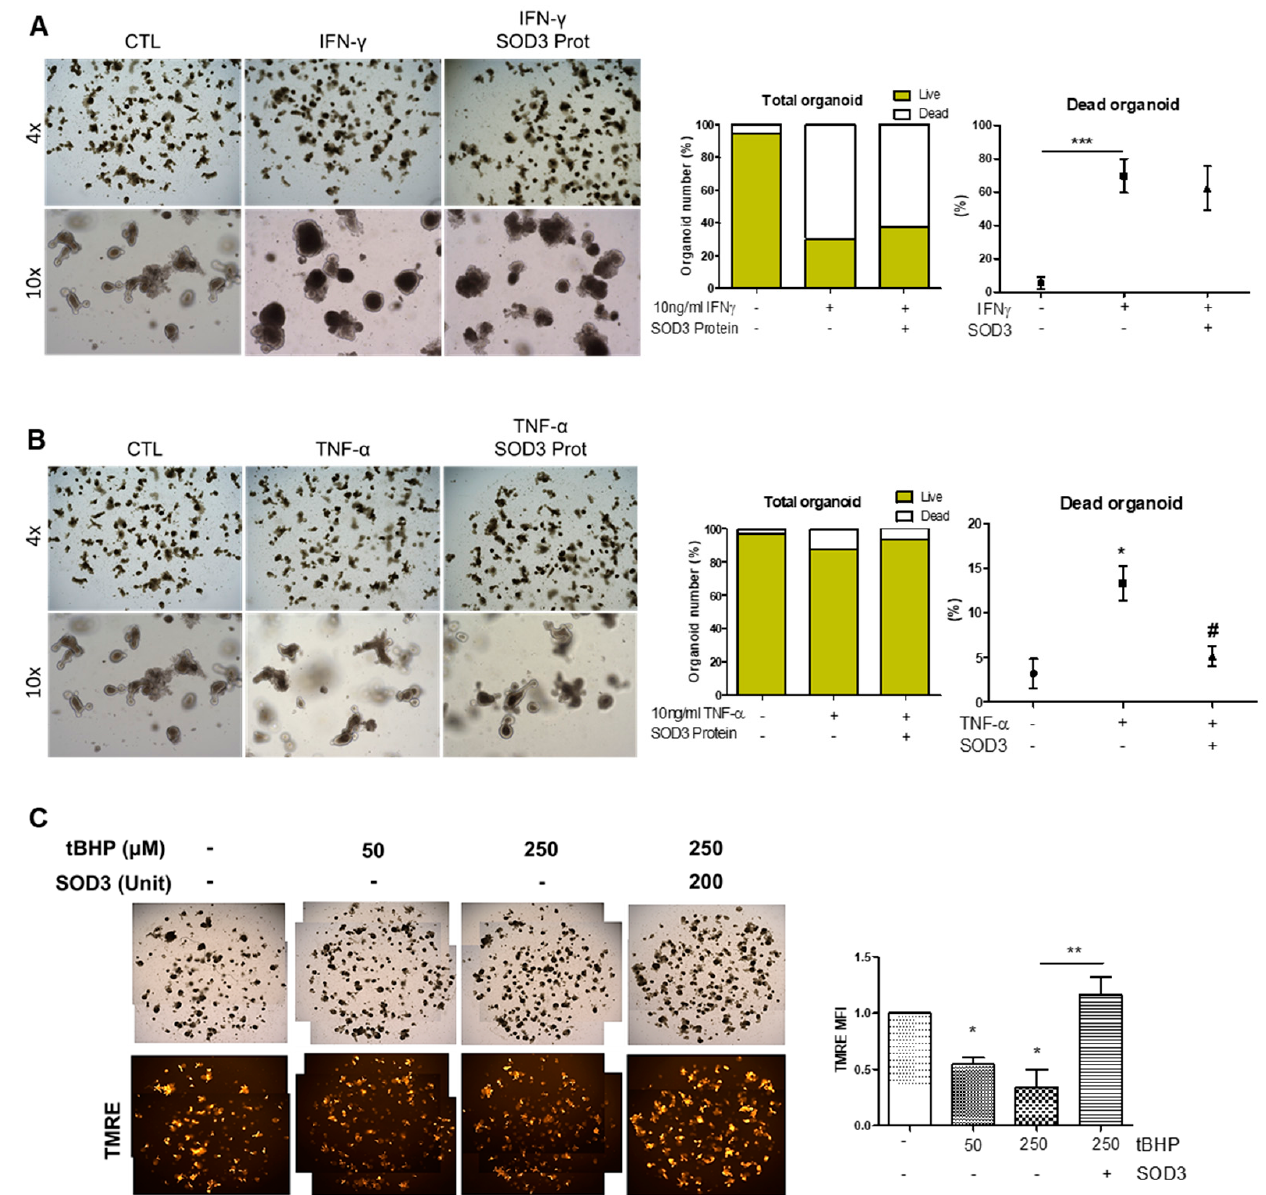
Figure 6. The protective action of SOD3 protein on IOs against pro-inflammatory and oxidative stress. ( A , B ) The representa- tive bright-field images and live/dead assessment of IFN- γ ( A ) or TNF- α ( B ) treated IOs on culture day 5. Cytokines were added on culture day 3. ( C ) To induce the generation of reactive oxygen species, tBHP was added to IO culture then their mitochondrial activity was determined by TMRE staining. Mean fluorescence intensity (MFI) of CTL was standardized as 1. At least three individual experiments were performed. * p < 0.05, ** p < 0.01, *** p < 0.001 (CTL vs. IFN- γ and TNF- α in A , B ; CTL vs. others in C ), # p > 0.05 (TNF- α vs. SOD3 protein). Results are shown as mean ± SD. Results show one representative experiment of at least three independent